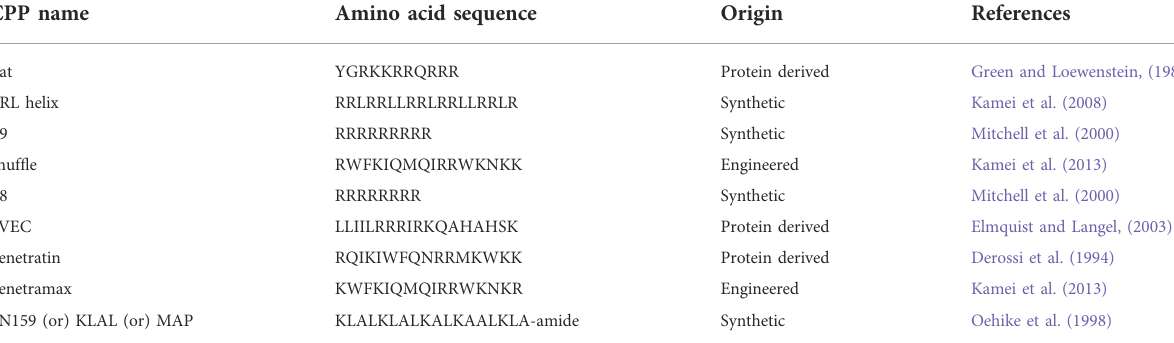
TABLE 1 Amino acid sequences of the various cell-penetrating peptides used in this